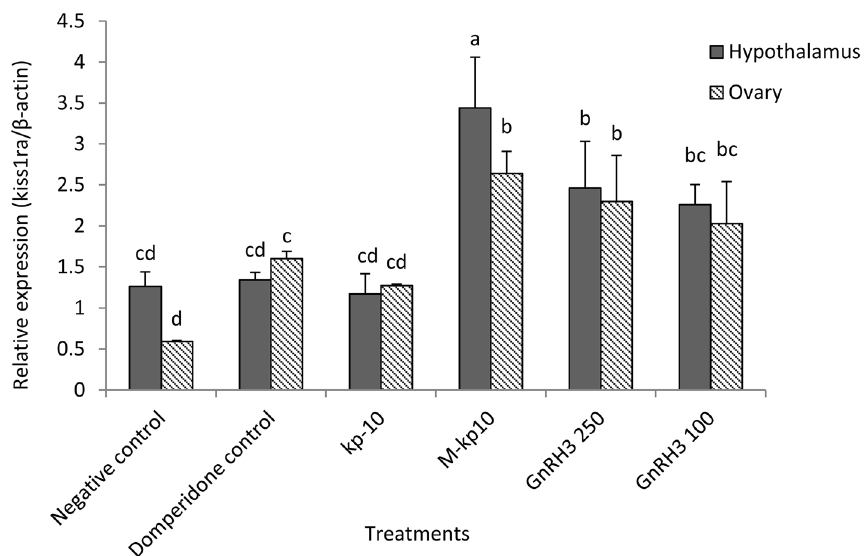
Figure 5. Changes in the expressions of kiss1ra gene in the ovarian and hypothalamus tissues of female goldfish based on the RT-PCR (The actb is considered as the control). The different letters above columns are showing significant differences based on one-way ANOVA and Tukey’s post hoc